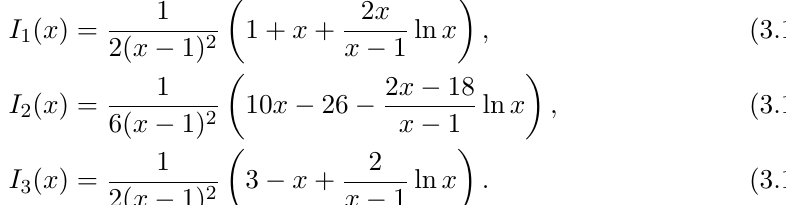
Figure 1 . The one-loop diagrams which contributes to d (cid:13) photon and a gluon respectively to the internal particles in all possible